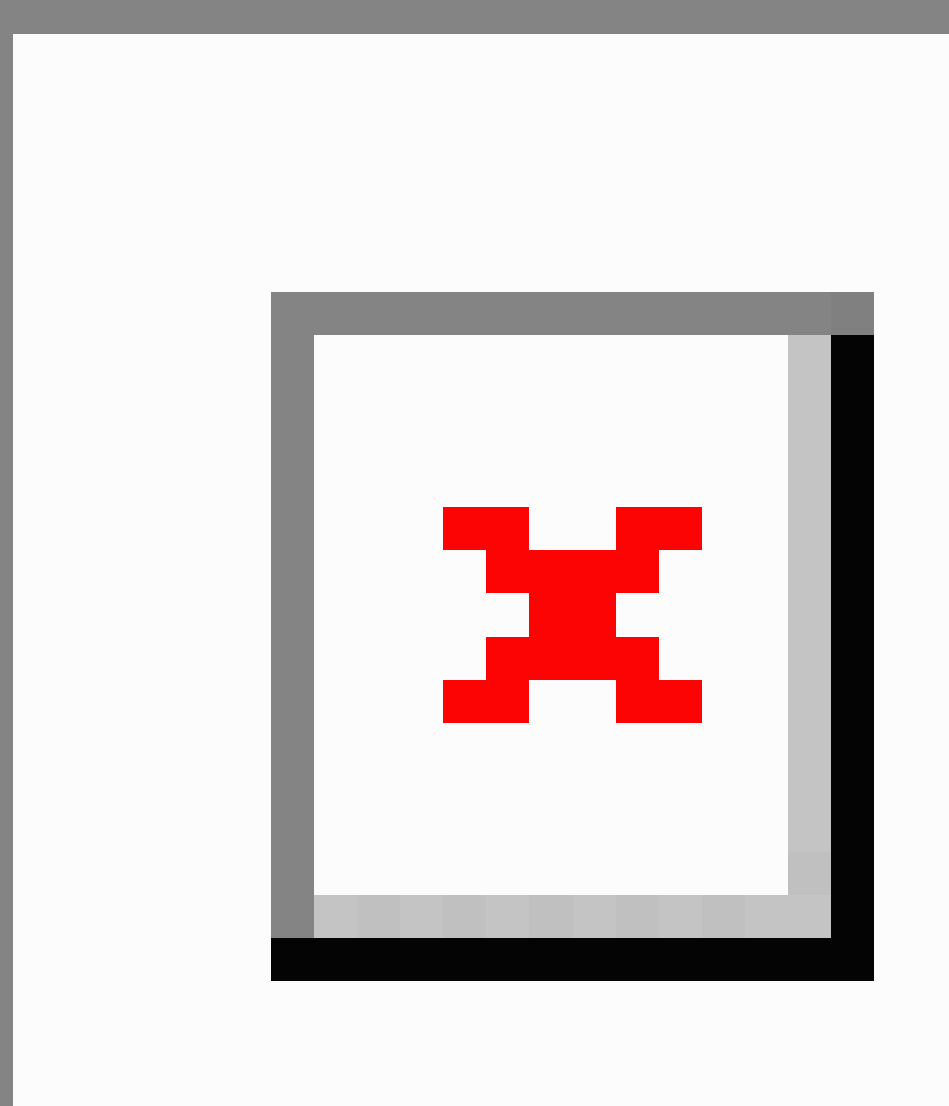
Figure 3. Box and whisker plots at baseline, one month, and three months for: (a) Generalized Anxiety Disorder-7 scores; (b) cynicism scores from Maslach Burnout Inventory; and (c) emotional exhaustion scores from Maslach Burnout Inventory. Significance level is denoted by asterisks: